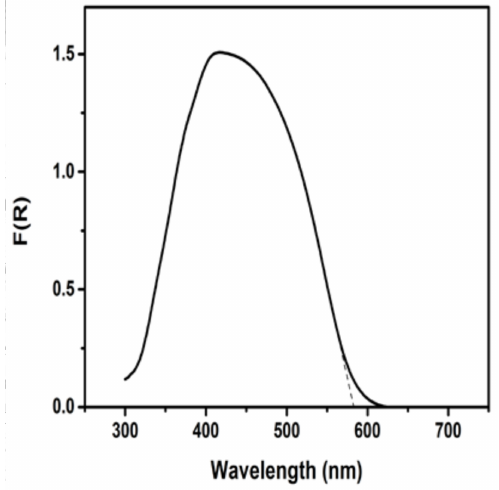
Figure 2. Diffuse reflectance absorption spectrum of the combined CdS/TiO 2 photocatalyst